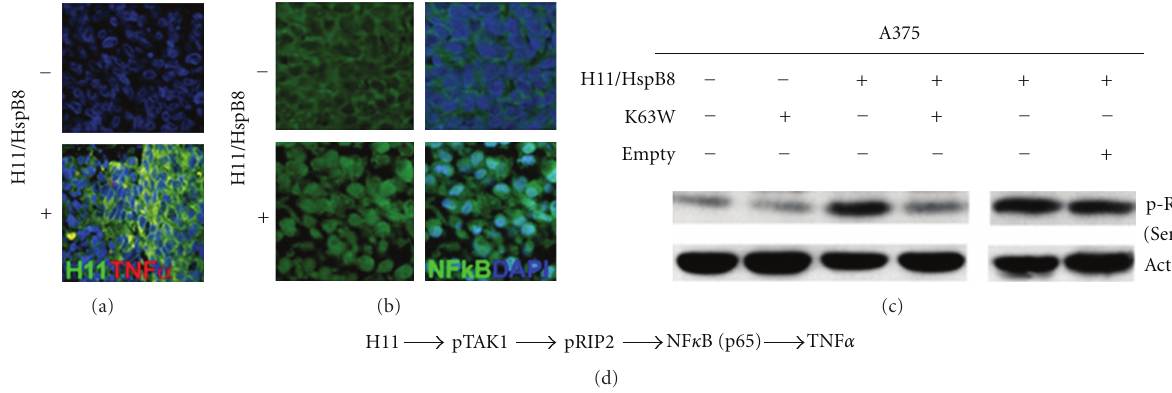
Figure 4: H11/HspB8 induces TAK1-dependent TNF- α expression. (a) Serial sections from A2058 and A375 xenografts collected at the end of the follow-up period from mice subjected or not to restored H11/HspB8 expression were stained with antibodies to H11/HspB8 (Alexa Fluor 488 conjugated secondary antibody; green) and TNF- α (Alexa Fluor 594 conjugated secondary antibody; red). (b). Serial sections from the A2058 and A375 xenografts as in (a) were stained with Alexa Fluor 488 conjugated NF- κ B p65 antibody. Restored H1/HspB8 activates NF- κ B (intranuclear localization). (c) A375 cells stably transfected with tet-inducible H11/HspB8 were given Dox to restore H11/HspB8 expression alone or with the TAK1 dominant-negative mutant K63W or empty vector. Extracts collected 3 days later were immunoblotted with antibody to pRIP2 (Ser176). They were stripped and reprobed with antibody to actin (loading control). (d) Schematic representation of the pathways involved in H11/HspB8-induced TNF- α